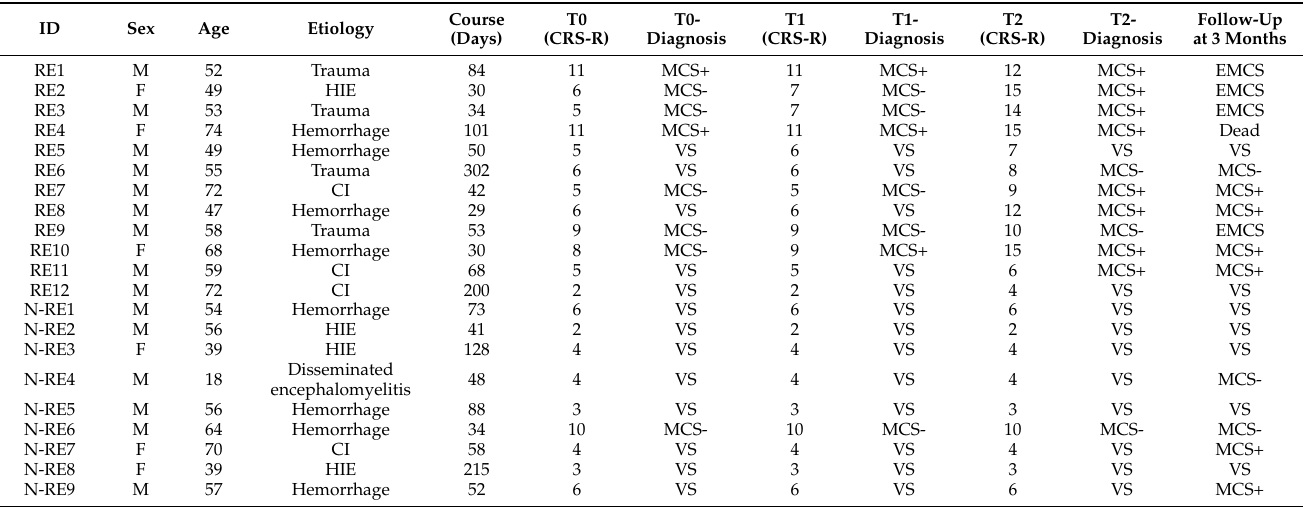
Table 1. Demographic information and clinical data of the patients.